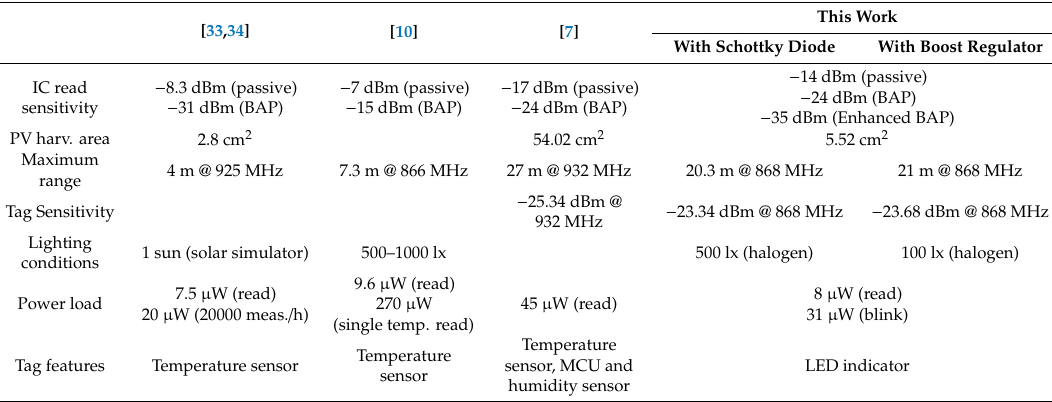
Table 5. Cost comparison (prices from Digi-Key or manufacturer